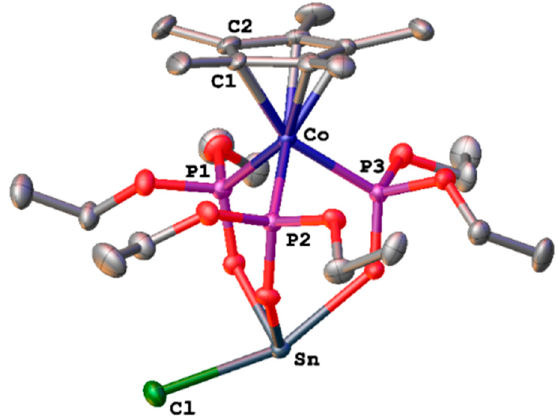
Figure 3. The molecular structure of 2b in the solid state. Thermal ellipsoids are set at 50% probability. Hydrogen atoms are omitted for clarity.